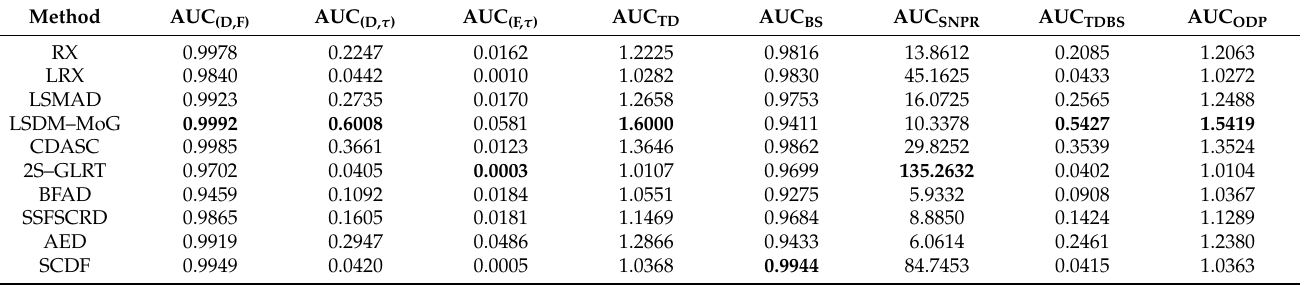
Table 4. Comparison of AUC performance of different methods on the MUUFL Gulfport